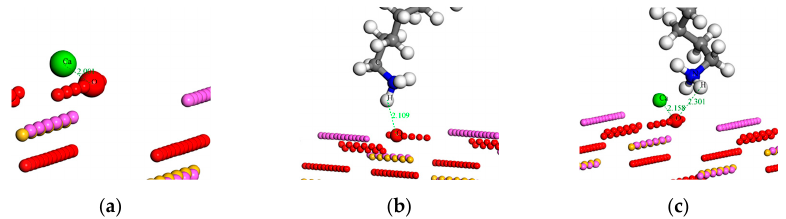
Figure 8. Optimized adsorption configurations of: ( a ) Ca 2+ ; ( b ) RNH 3+ ( N); and ( c ) Ca 2+ + RNH 3+ (CN) on the sillimanite (010) surface (atom color: green = Ca, white = H, gray = C, blue = N).